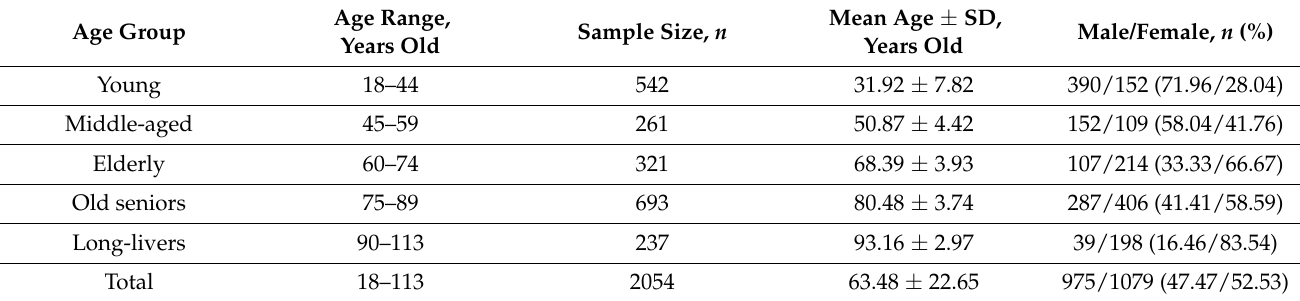
Table 4. Characteristic of studied